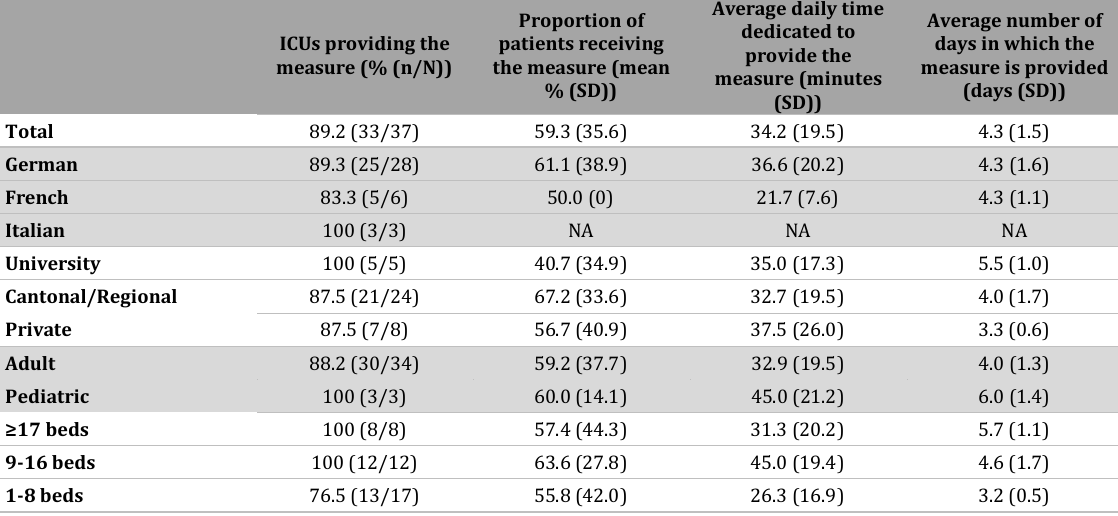
Table S9. Active range of motion muscle activation and training